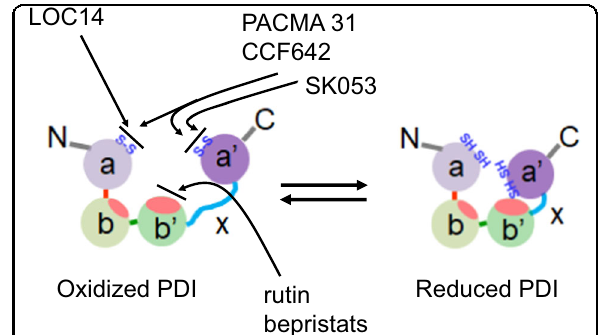
Fig. 2 PDI activity in the extracellular region. As the redox environment outside the cell is reducing compared to the highly oxidizing ER environment, PDI is likely to function as a reductase in the extracellular milieu. The binding sites of some PDI inhibitors to oxidized PDI are